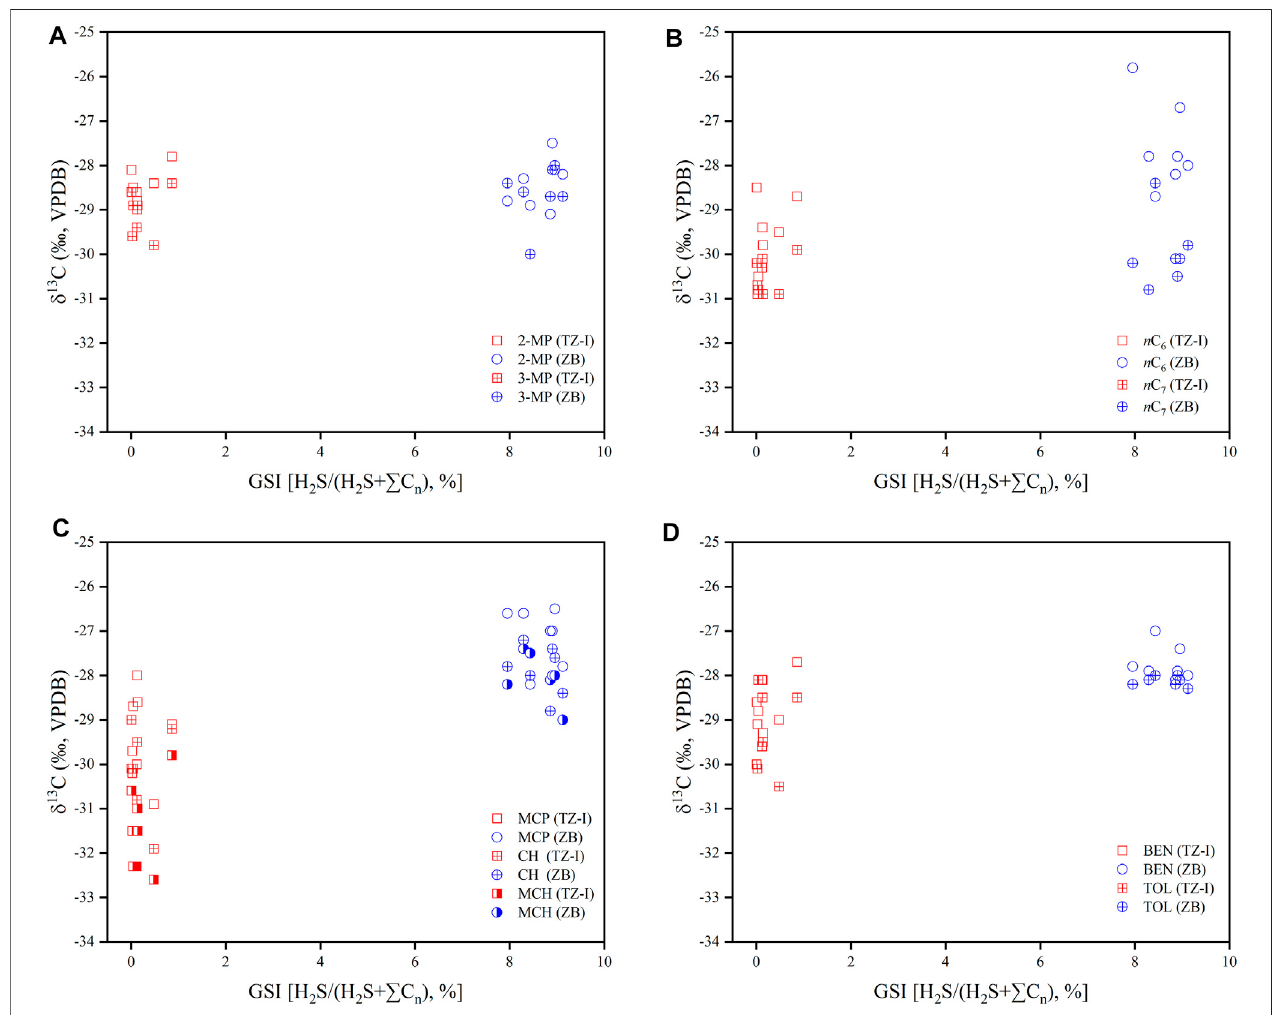
FIGURE10 | The cross plot ofH 2 S/(H 2 S+ (cid:1) C n ) and 13 Cfor individual LHs [ (A) 2-MPand 3-MP, (B) n C 5 and n C 6 , (C) MCP, CH and MCH, (D) BEN and TOL]in the TZ-I and ZB gas fi elds.